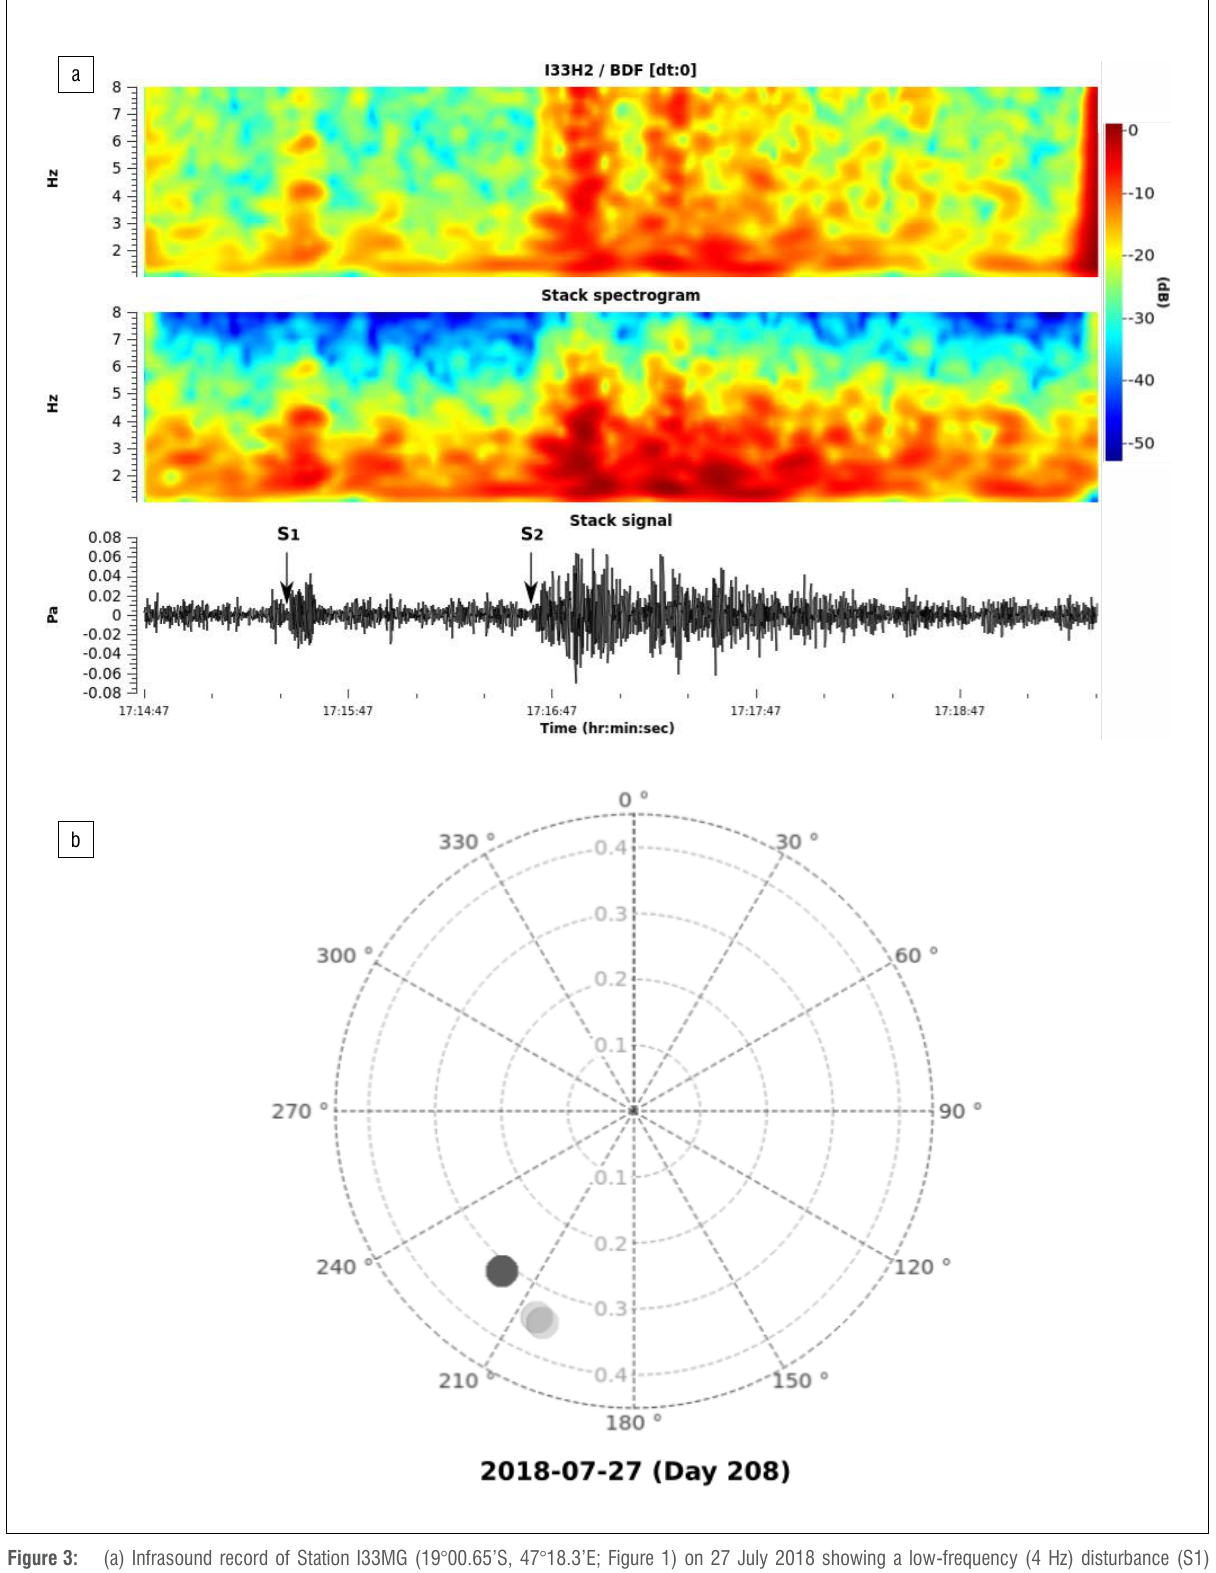
Figure 3: (a) Infrasound record of Station I33MG (19°00.65’S, 47°18.3’E; Figure 1) on 27 July 2018 showing a low-frequency (4 Hz) disturbance (S1) commencing at 17h15:27 UTC (19h15:27 local time) for 10 s and a second disturbance (S2) commencing at 17h16:24 UTC for 150 s. The upper spectrogram indicates the energy of the signal at one of the four elements (I33H2) at the station. The lower spectrogram is the signal stack of all four elements of the station. The low frequency and the prolonged nature of the signal are consistent with bolide-generated infrasound waves. 21,29 (b) Polar diagram showing the azimuth of detection of the first (grey dots; at 206°) and second (black dot; at 220°) waves. Based on the bolide timing and hypocentre location established from the seismograph data and fall parameters, the calculated celerities of the two waves (0.305 km/s and 0.301 km/s, respectively) are consistent with stratospherically ducted